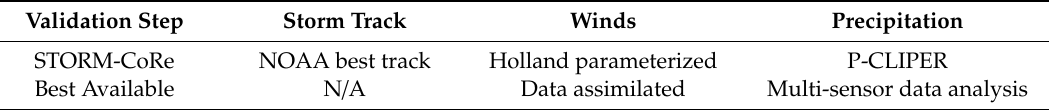
Table 1. Di ff erence in meteorological input for two-step validation